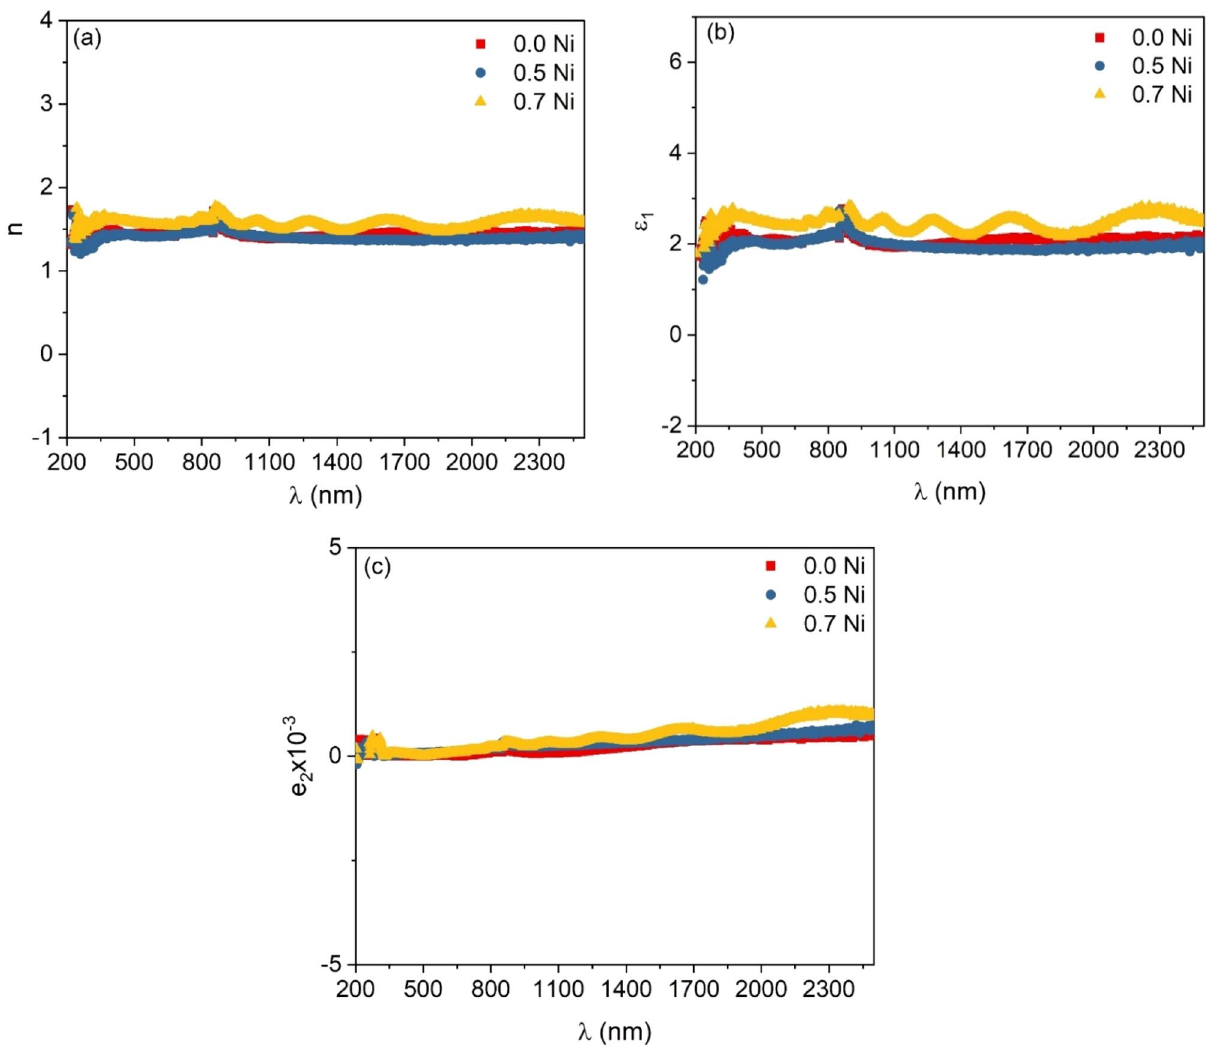
Figure 6. ( a ) The refractive index change, and ( b,c ) the variation of two components of dielectric constant with the photon wavelength of SMZC: (0, 0.5, 0.7)Ni films.